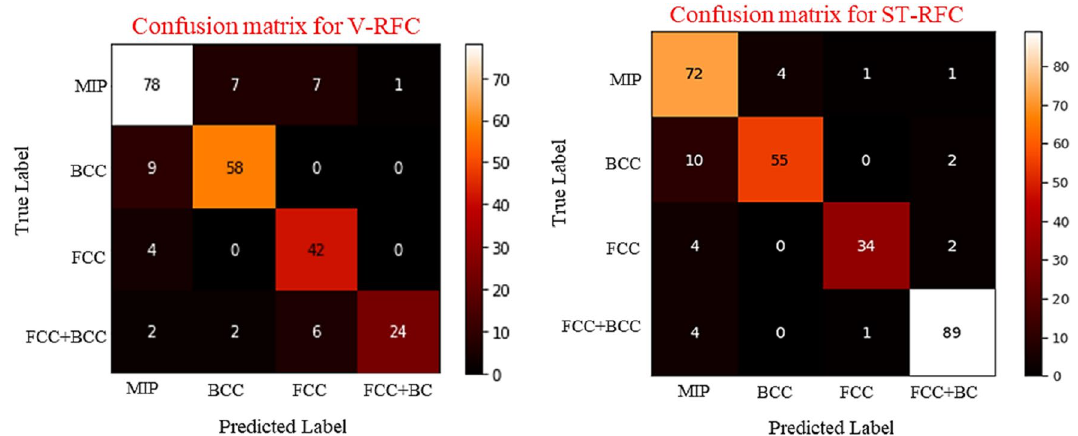
Figure 5. Confusion matrix comparing the performance of V-RFC, and ST-RFC for each distinct phase.